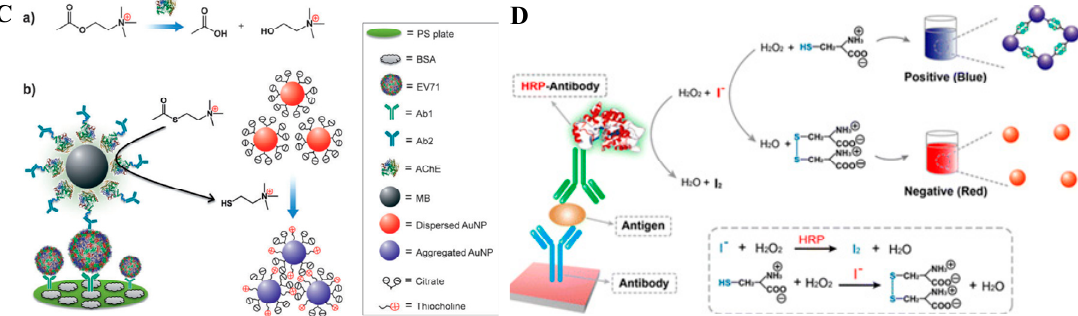
Figure 9. ( A ) Naked-eye readout of plasmonic immunoassays. Detection of target protein via the